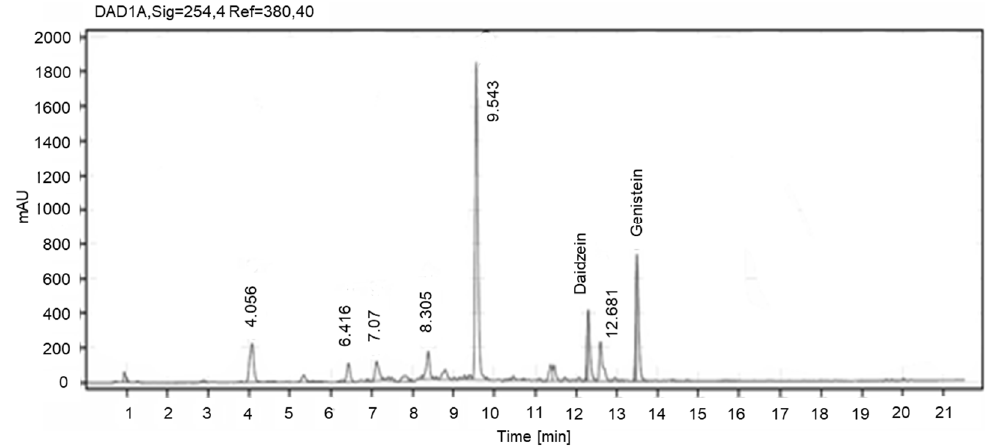
Figure 3. Representative HPLC-UV chromatographic profile for NADES extracts of soy molasses. Table 2. Results of quantification of the isoflavones in ethyl acetate fractions of kudzu roots (KR) and soy molasses (SM).